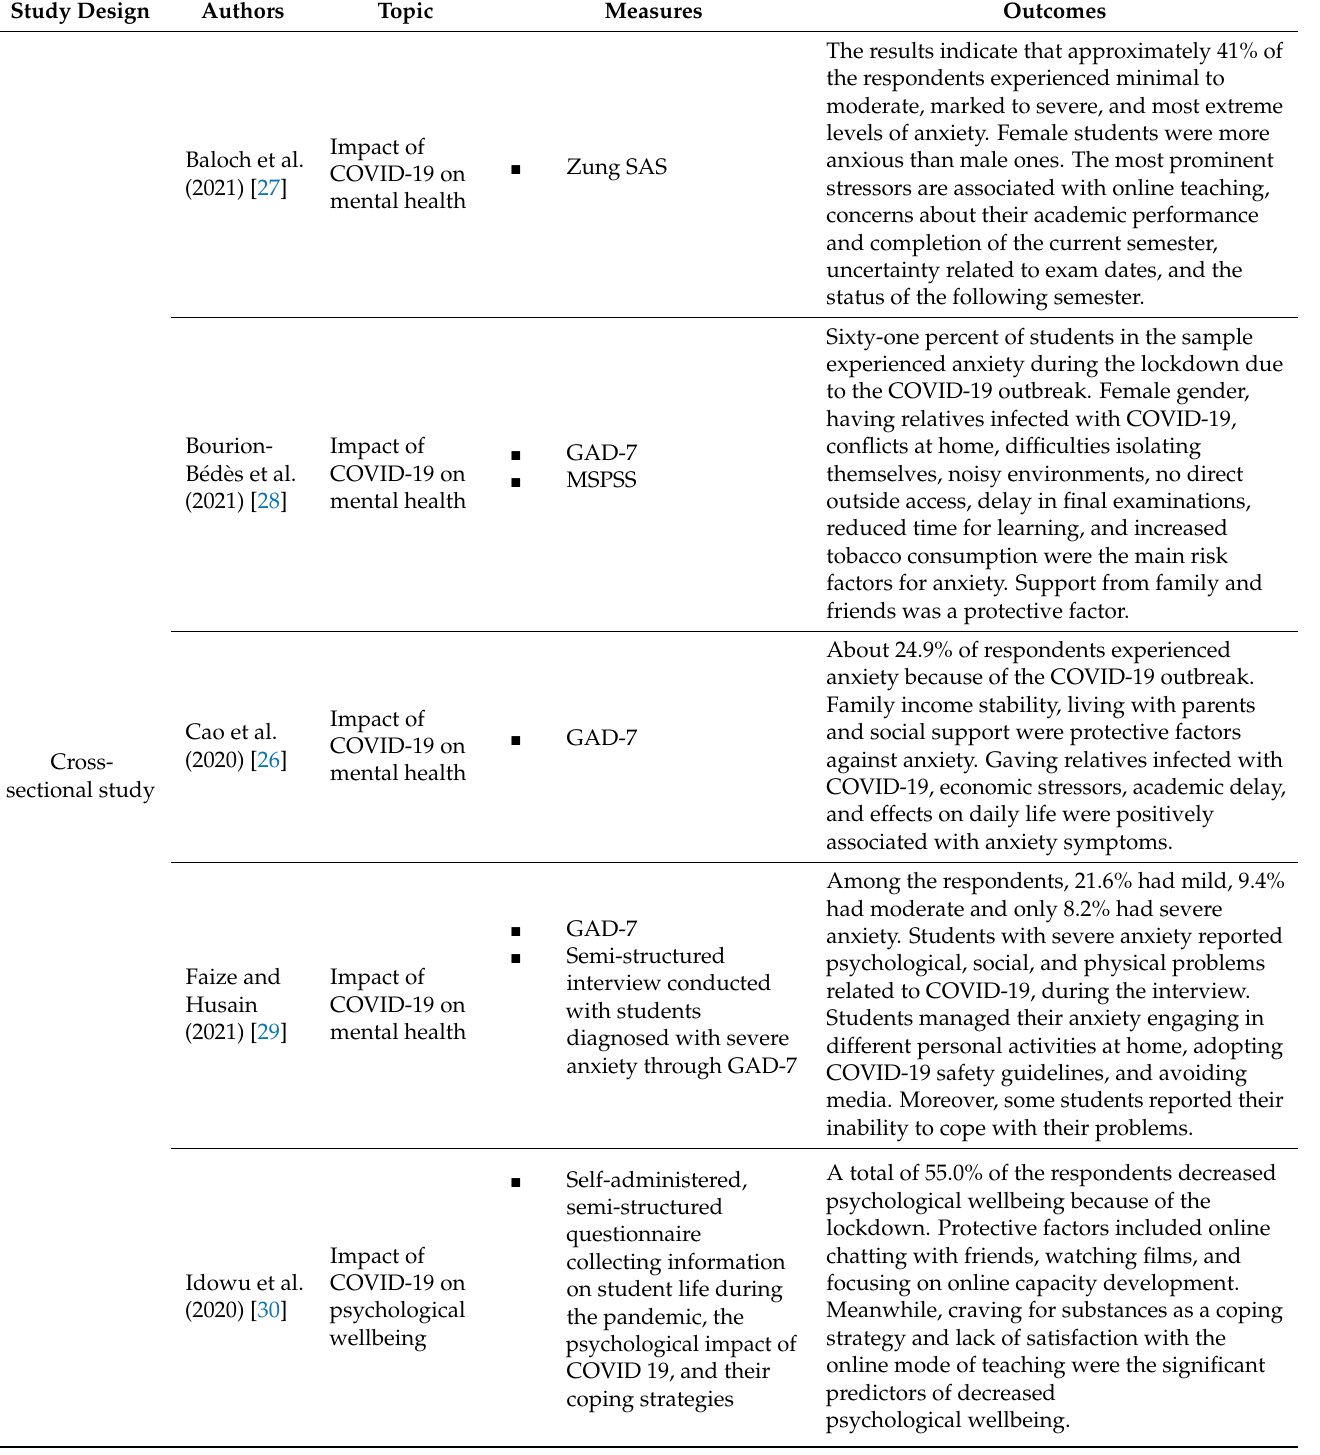
Table 3. Summary of included studies evaluating the psychological impact of COVID-19 among young people. Study